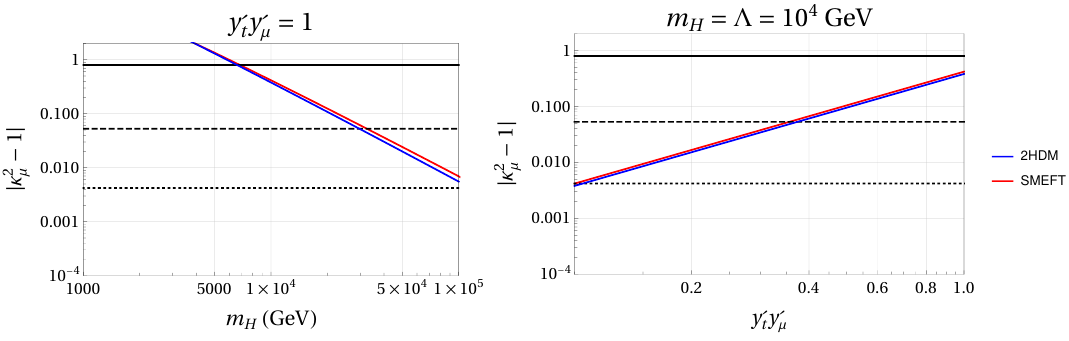
Figure 9 . Left : shift to h → µ + µ − decay for different values of m H , with fixed couplings to top and muon, compared to the present and future collider sensitivity, represented by the black solid (LHC), dashed (HL-LHC) and dotted (FCC) lines (see section 4.2 for details). Blue and red lines represent the full 2HDM contribution in eq. (5.11) and the SMEFT running and matching, with eq. (5.10) as initial condition, respectively. Right : total shift for different values of the product y 0 y 0 , with fixed m H = Λ = 10 t µ